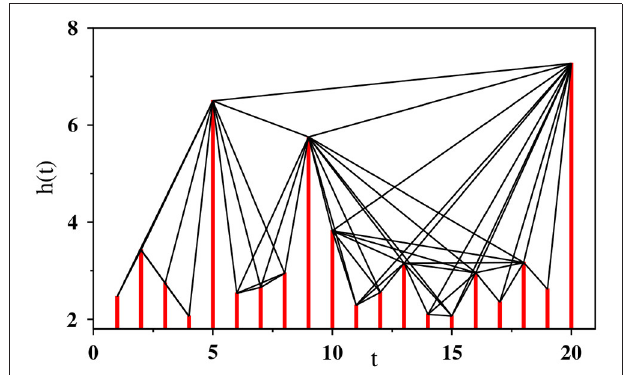
FIGURE 1 | Visibility graph representation of a synthetic time series with 20 data values drawn randomly from an exponential distribution, where t i the time t corresponding to the i -th data. Each vertical bar representing the height variable h is considered as a node and if the top of one bar is visible from the top of the another then a link is placed between the corresponding pair of nodes.